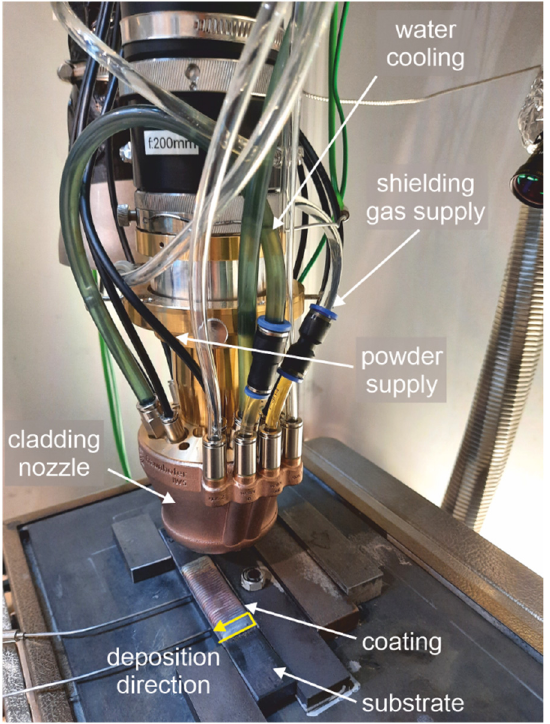
Figure 1. The test assembly with the sample after laser cladding process.